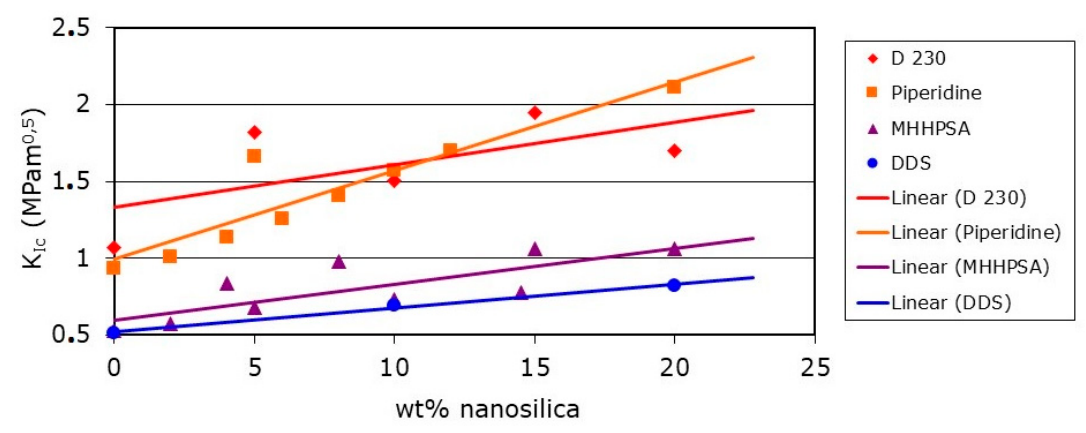
Figure 6. DGEBA epoxy resin fracture toughness using K Ic as a function of silica nanoparticle content for di ff erent curing agents [13].